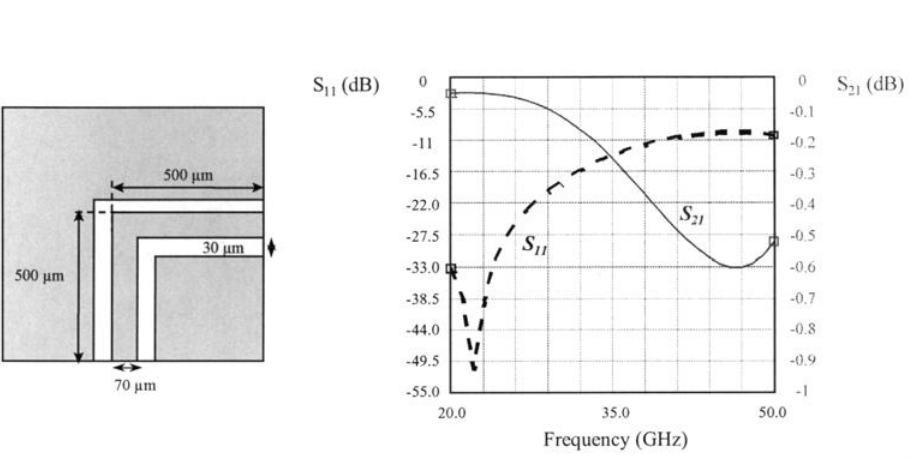
FIGURE 8 Schema and electromagnetic simulation of the bend